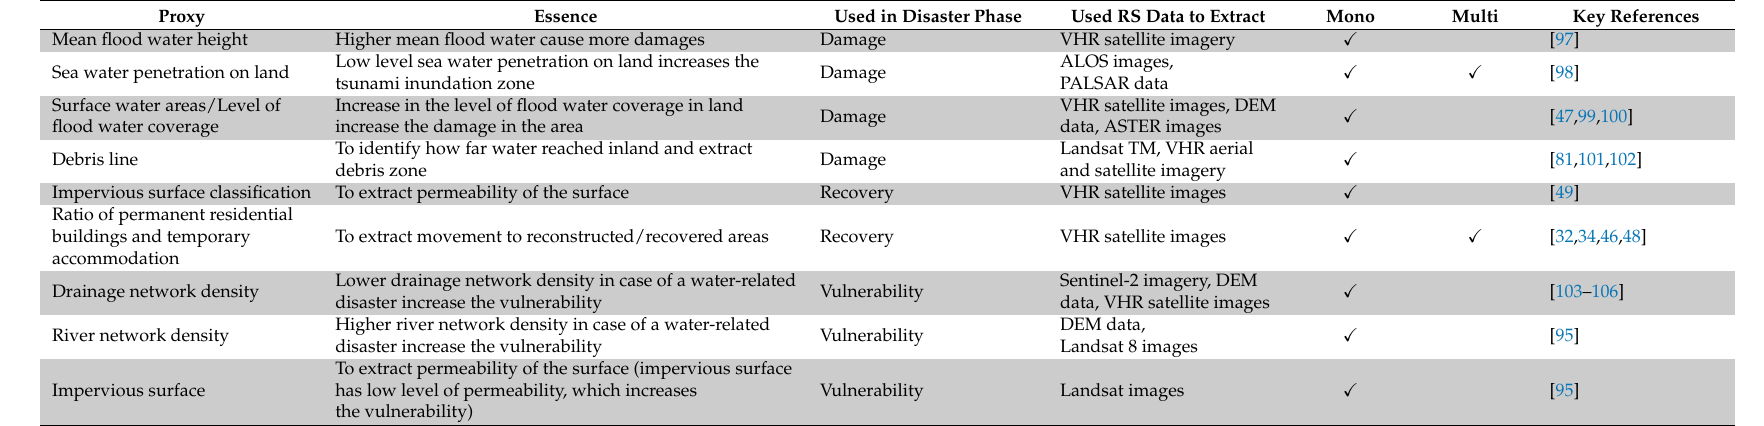
Table 3. Remote sensing-based built-up proxies for urban DRM, Others category. Mono and Multi refer to mono-temporal and multi-temporal RS data that used for extraction,